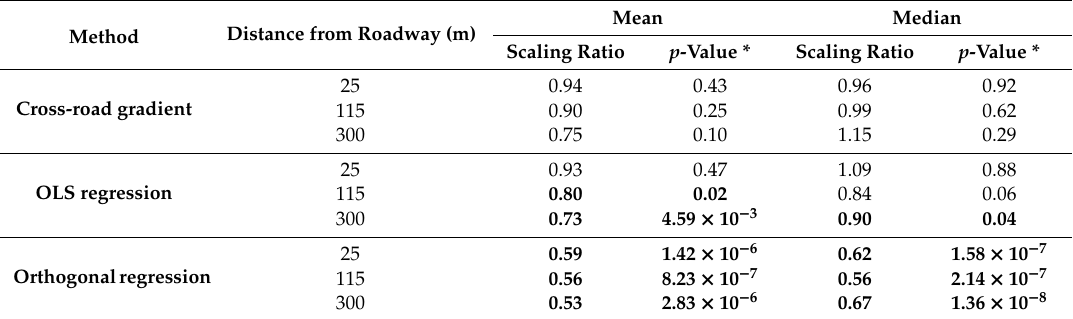
Table 2. MOVES NO x emissions scaling factors based on each ambient data method uncorrected for CO bias. Statistically significant results shown in bold